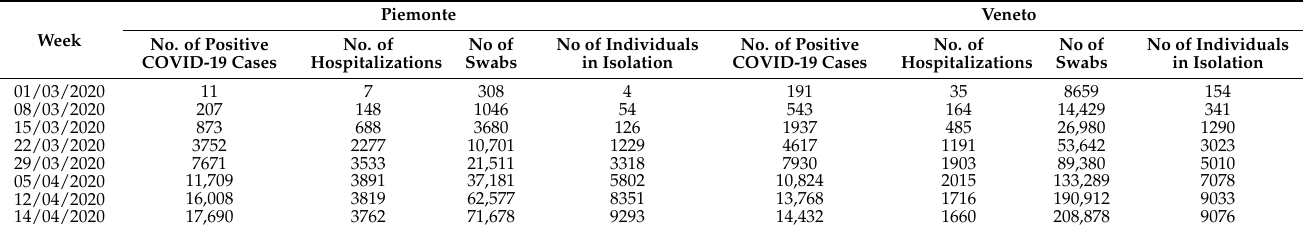
Table 1. Weekly number of positive COVID-19 cases, hospitalizations, swabs performed, and individuals in isolation at home in Piemonte and Veneto.